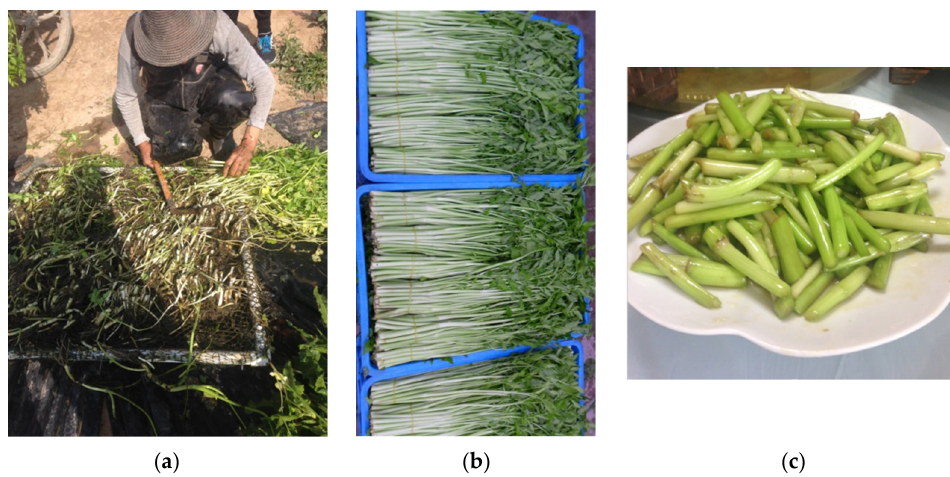
Figure 3. Harvest process of water dropwort for LW purification. ( a ) Reaping the plants from the floating beds; ( b ) water dropwort vegetable products for sale; ( c ) A common dish procured from water dropwort in China.